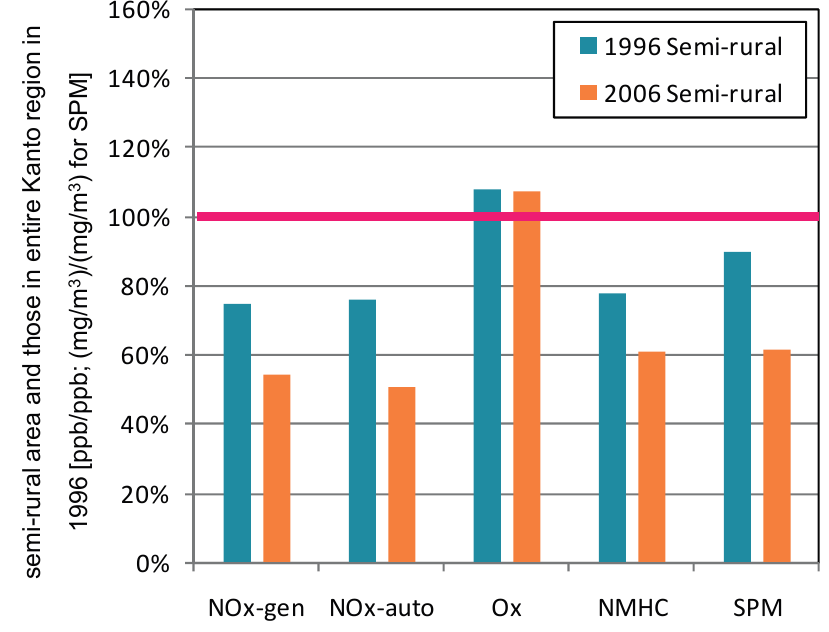
Figure 6. Ratio between average pollutant concentrations in semi-rural area and those in entire Kanto region during 1996. Average concentration in entire Kanto region during 1996 corresponds to 100%.